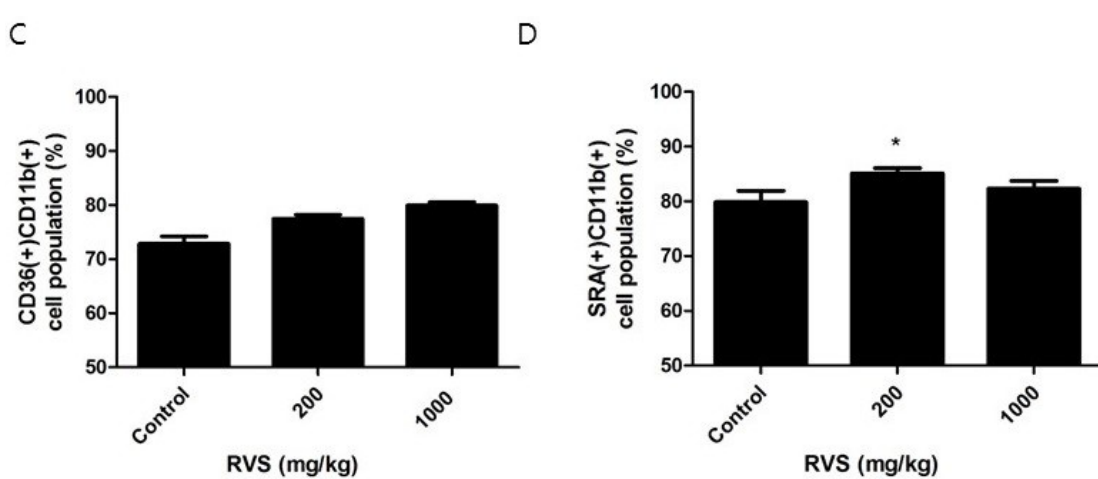
Figure 1. Effects of Rhus verniciflua Stokes (RVS) extract on the percentage of monocyte-derived macrophages in peritoneal exudate cells. Mice were orally given RVS extract (200 or 1000 mg/kg) for 10 days. On day 10, peritoneal exudate cells were obtained following the final administration of RVS. Intraperitoneal injection of thioglycollate was performed 4 days before the isolation of peritoneal exudate cells. ( A , B ) Peritoneal exudate cells were double-stained with FITC-labeled anti-CD11b and PE-labeled anti-CD36 antibodies ( A ) or FITC-labeled anti-SRA and PE-labeled anti-CD11b antibodies ( B ) and analyzed via flow cytometry. Representative dot plots are shown. ( C , D ) The bars represent the mean ± standard error of the mean (SEM) ( N = 6). Statistical differences between groups were determined using Student’s t -test. * p < 0.05 vs. control.